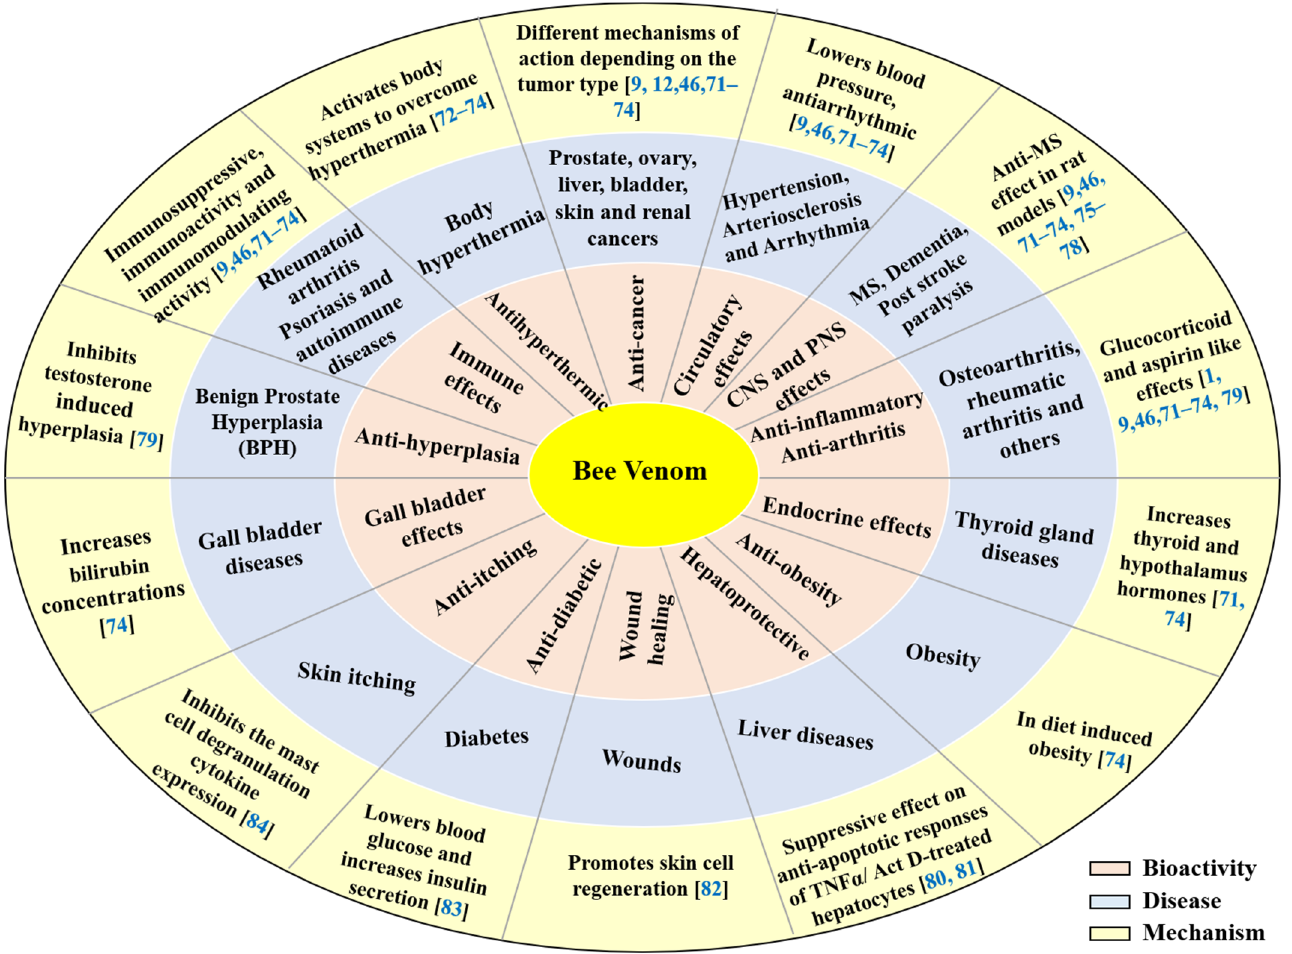
Figure 4. Therapeutic effects and mode of actions of bee venom. Abbreviations: CNS, central nervous system; PNS, peripheral nervous system; MS, multiple sclerosis; BPH, benign prostate hyperplasia; TNF- α , tumor necrosis factor- α ; Act D-treated hepatocytes, actinomycin D-treated hepatocytes.